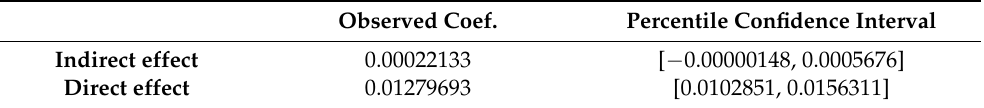
Table 5. The result for Bootstrap test.